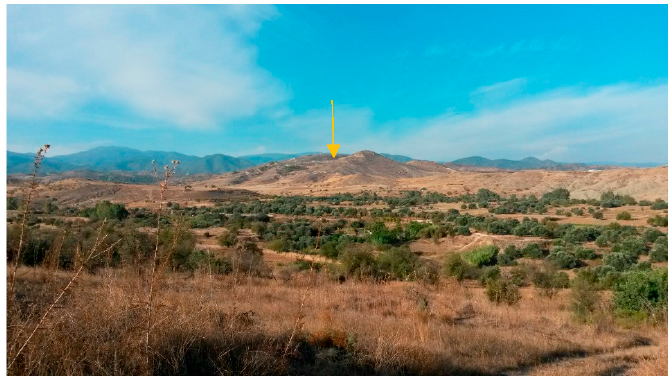
Figure 5. View of the KM site looking from the SSW. Yellow arrow showing the study area between the two topographic highs. Peristerona River valley in the foreground. Table 1. Kato Moni borehole collar information (UTM / UPS WGS84 co-ordinate